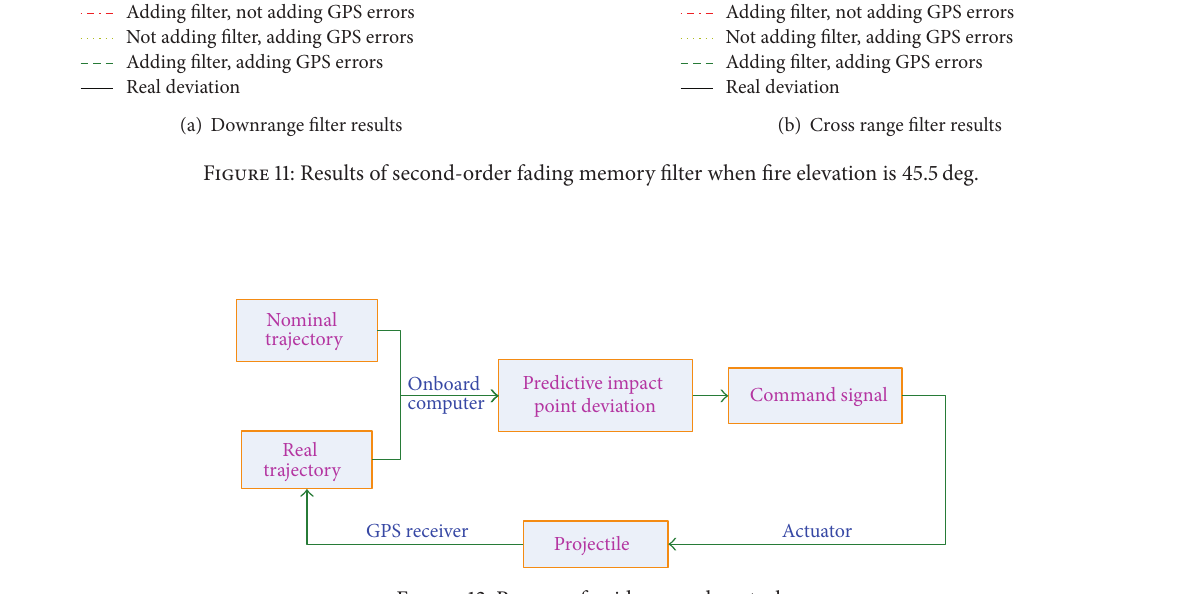
Figure 12: Process of guidance and